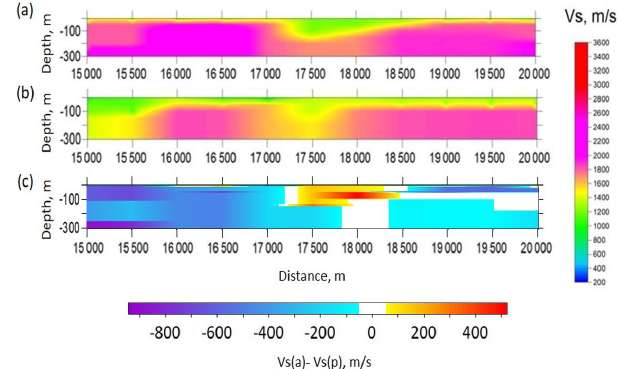
Figure 14. Velocity models calculated by inversion of dispersion curves along the part of Sakatti profile marked by blue in Fig. 9. (a) S-wave velocity model obtained using passive seismic data; (b) S-wave velocity model obtained using seismic data, which con- tain signals produced by a controlled source; (c) differences be- tween S-wave velocity models in panels (a) and (b)